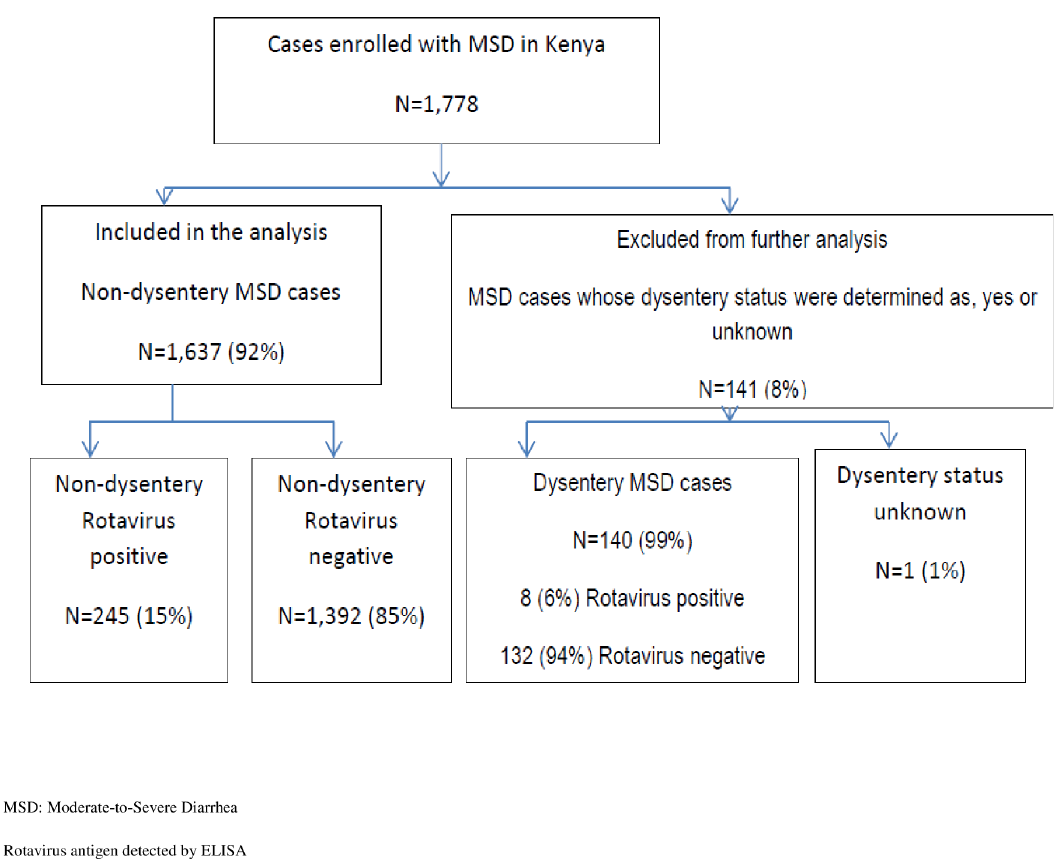
Fig 2. Flow diagram of enrollment of MSD cases in GEMS-Kenya, and the number of non-dysenteric MSD rotavirus-positive and negative cases used for analysis, western Kenya 2008 –